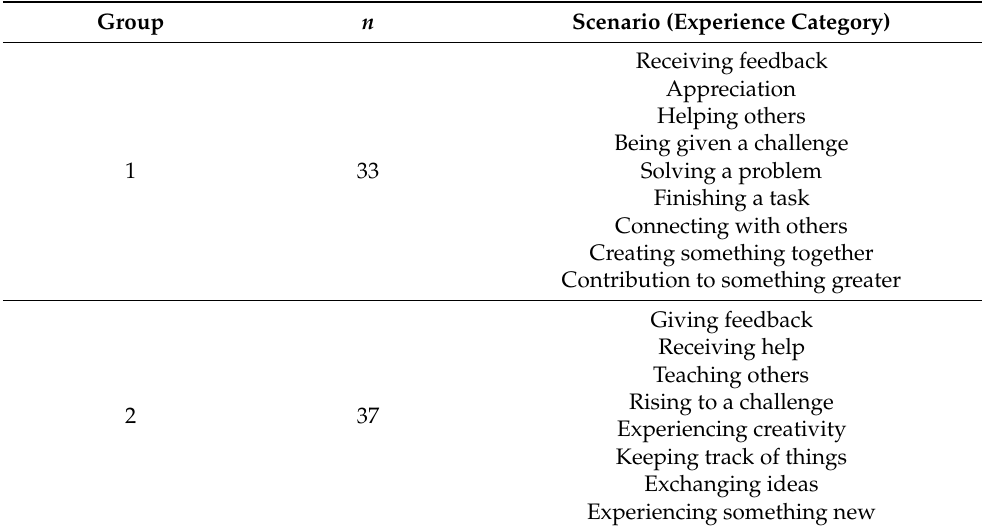
Table 5. Assignment of scenarios (listed in experience categories) to Groups 1 and 2 in the online survey. Group n Scenario (Experience Category)